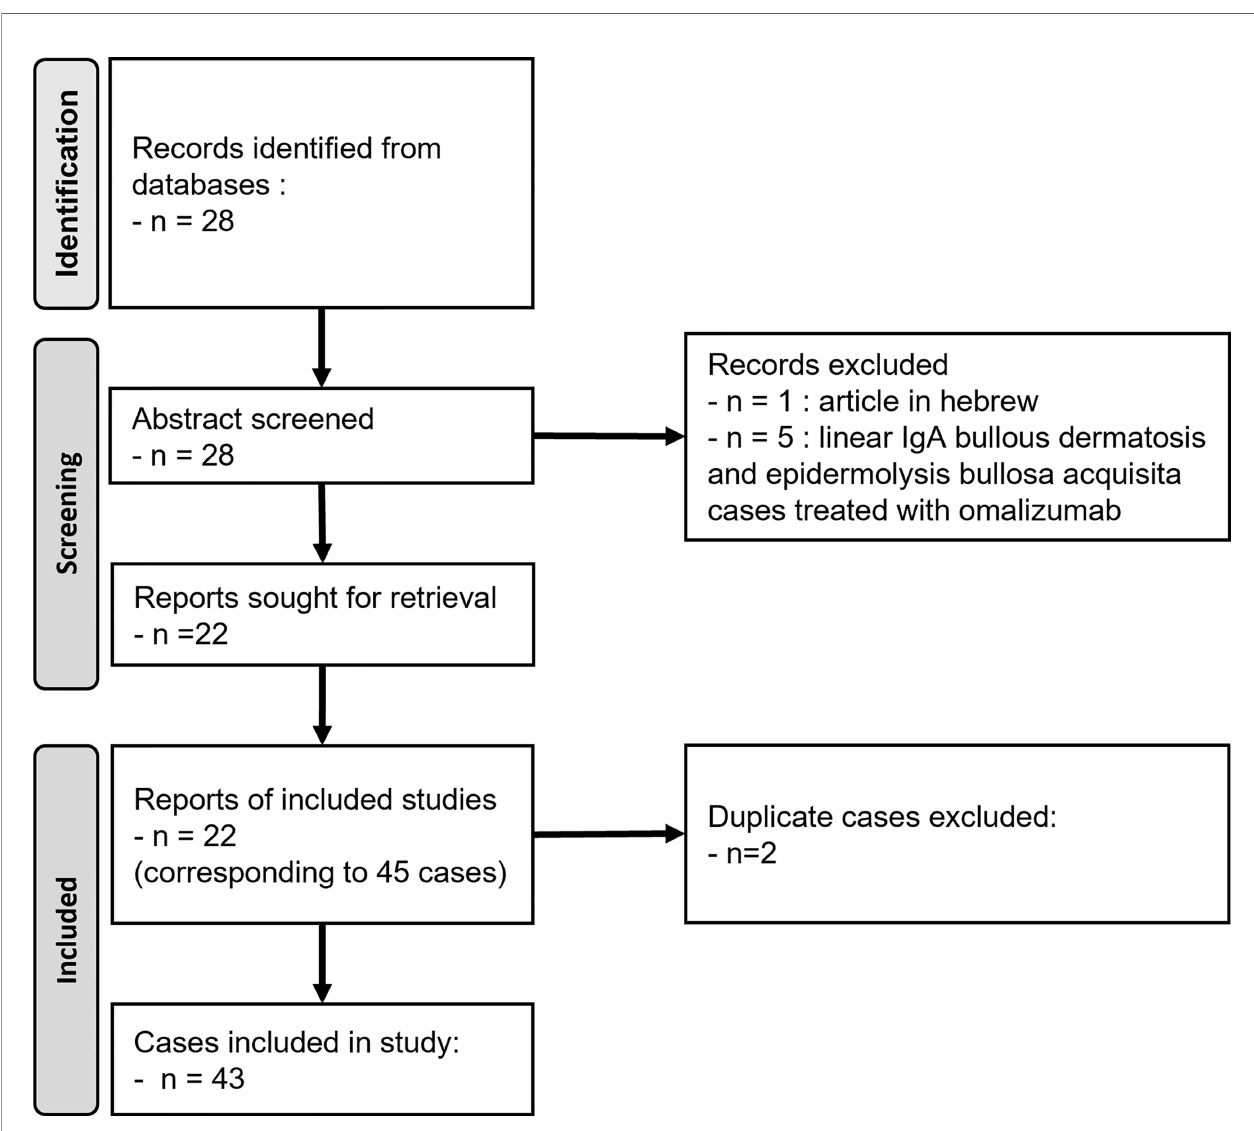
FIGURE 1 | Flow diagram for the literature review on BP/MMP cases treated with